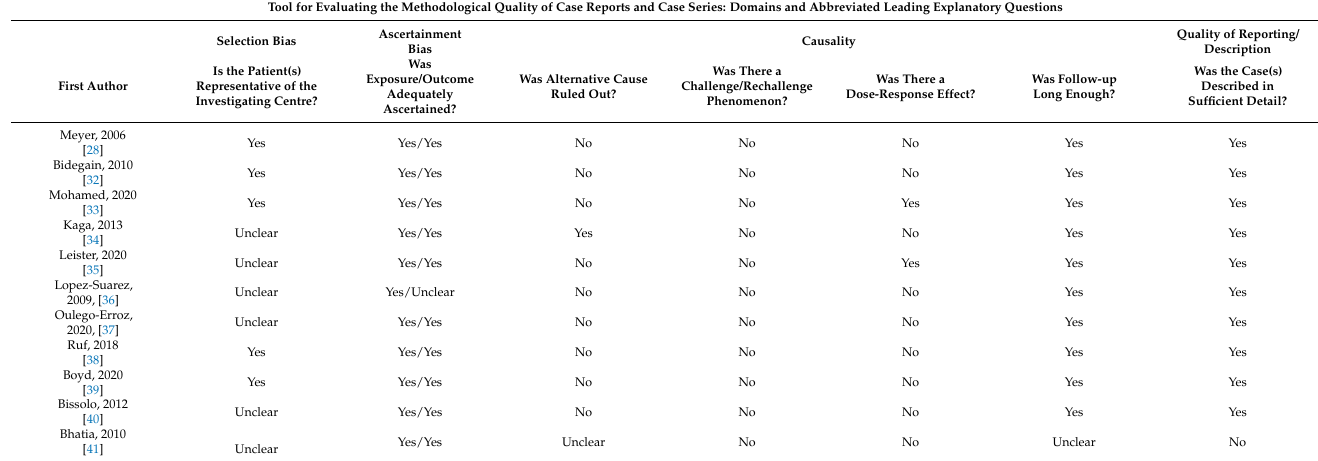
Table 3. Risk of bias assessment of individual case series, case reports, and case studies.